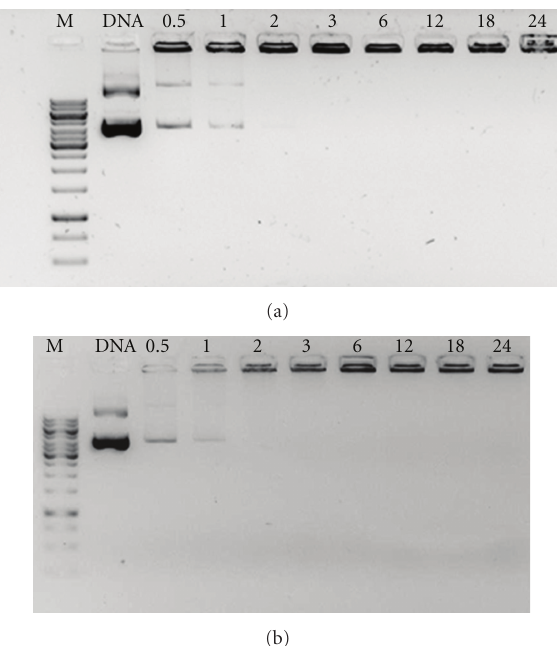
Figure 1: Electrophoretic retention of DNA by CH (a) and CHimi (b). Unless otherwise mentioned, lanes assignments correspond to N/P molar ratios tested and are as follows: Lane M: gene ruler 1kb DNA ladder; lane DNA: plasmid DNA solution; lane 0.5–24: N/P molar